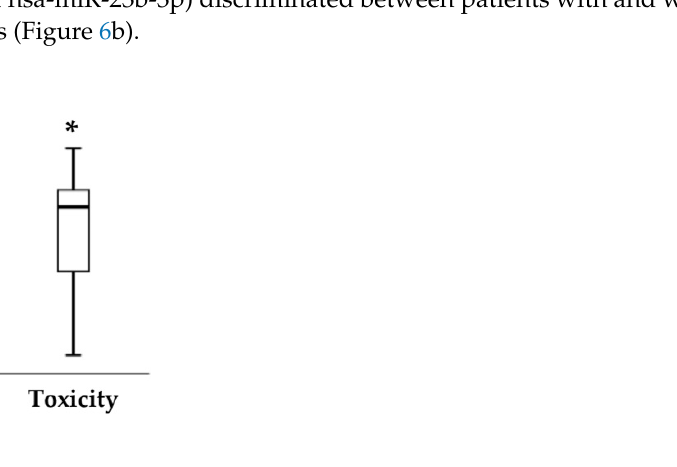
Figure 4. miR-92a-1-5p detected in a primary tumor indicates treatment toxicity. This miRNA determined by qRT-PCR in diagnostic tumor biopsies correlates with toxicity development upon regorafenib treatment (non-toxicity, n = 16; toxicity, n = 16). miRNA levels are expressed as the delta-crossing threshold (DCT); the mean of miR-103a-3p Cq and miR-30c-5p Cq was used as a normalizer Cq. Only miRNAs showing a statistically significant association between the two represented categories are shown. Data are presented as the median and interquartile range, with * p < 0.05, ° outliers values.